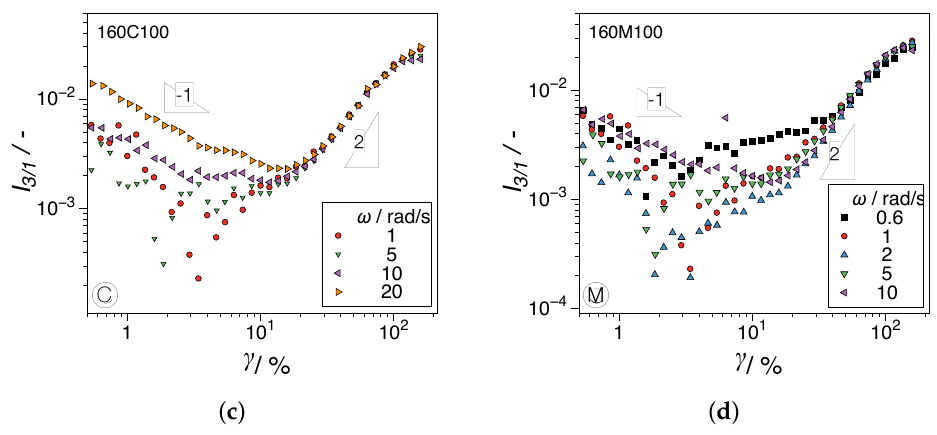
Figure 6. Strain amplitude dependence of the third relative higher harmonic, I 3/1 , at various angular frequencies for: ( a ) EBA, ( b ) EBA-GnP, ( c ) 160C100 and ( d )